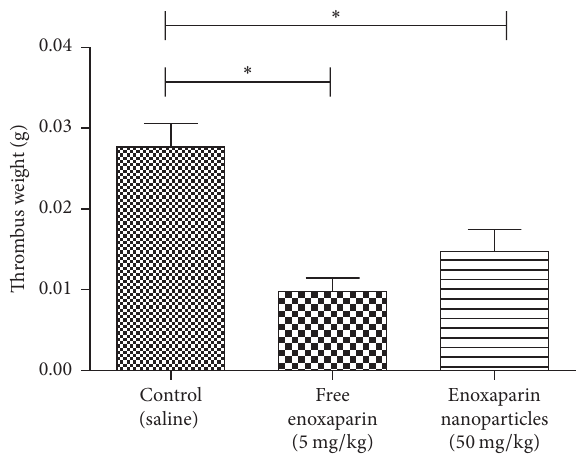
Figure 4: Antithrombotic effect shown through the comparison of thrombus weight of animals after surgery and subcutaneous treat- ment ( 𝑛 = 6 animals per group). ∗ 𝑃 = 0.0005 . 𝑃 value was calculated using ANOVA.